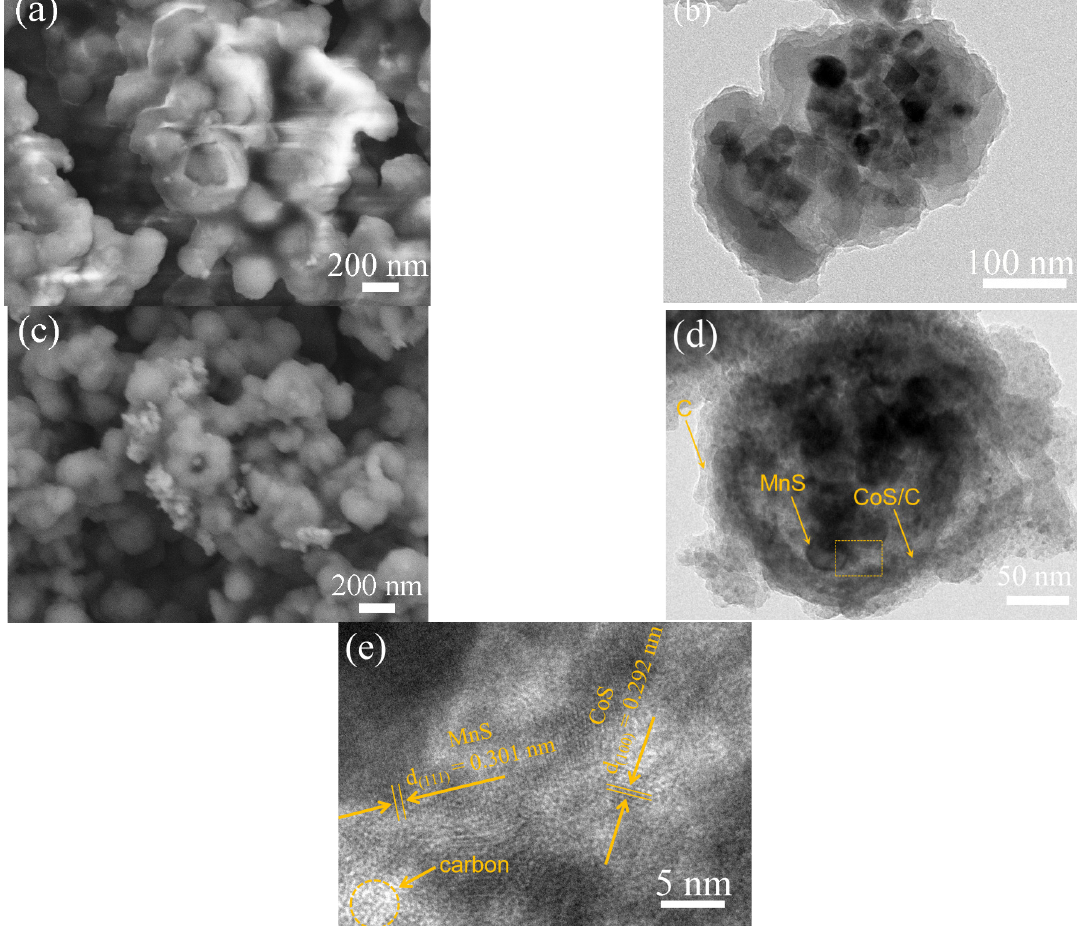
Figure 3. ( a ) SEM and ( b ) TEM images of MnCO 3 @ZIF-67@RF resin; and ( c ) SEM, ( d ) TEM and ( e